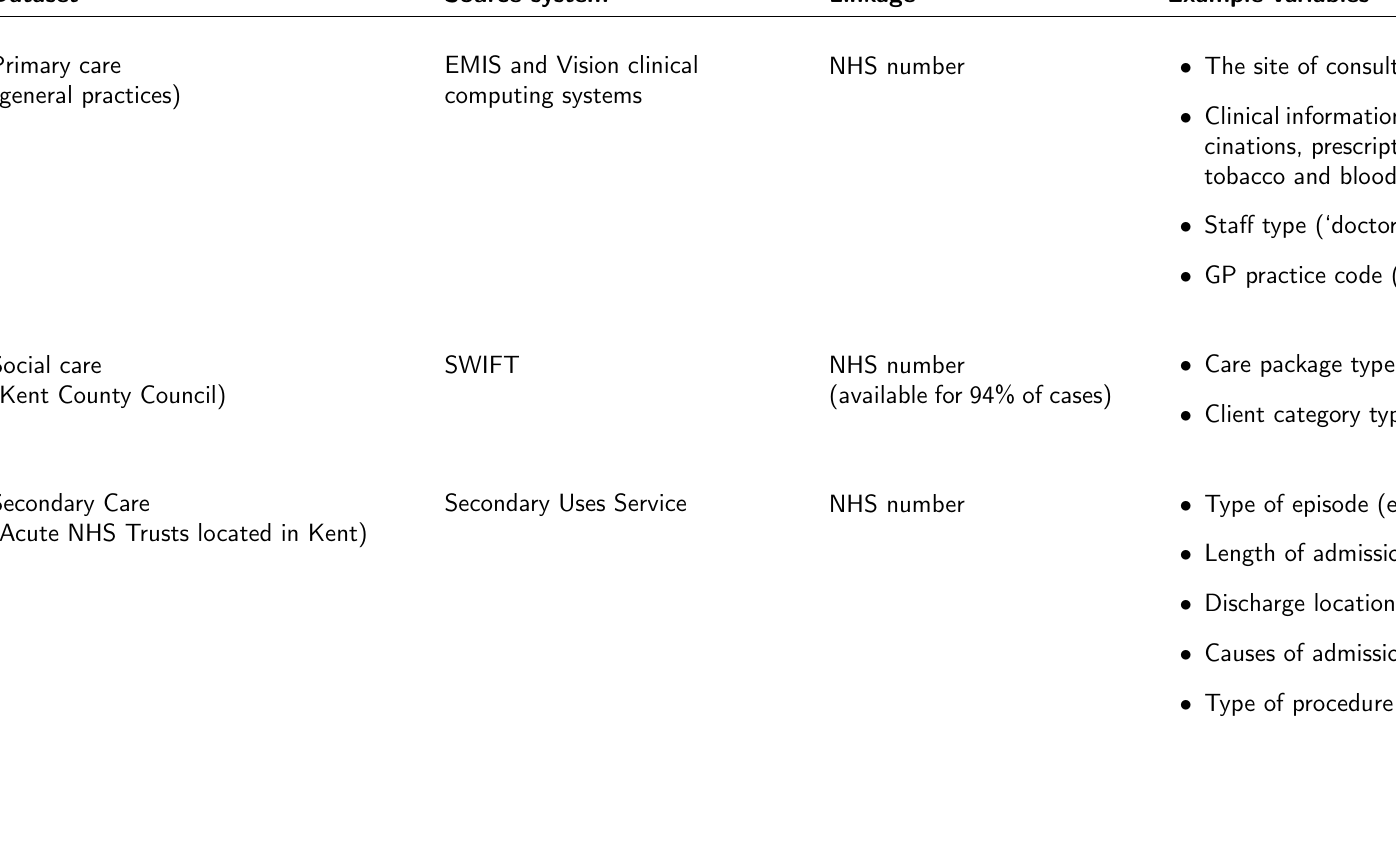
Table 2: Selected datasets included in the Kent Integrated